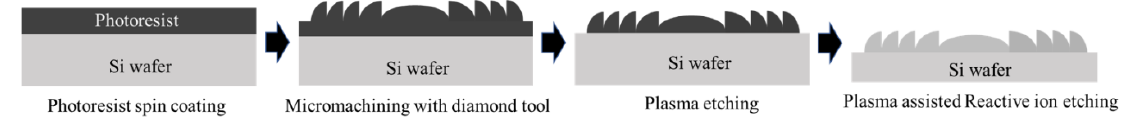
Figure 3. Schematic illustration of the micromachining process on a Si